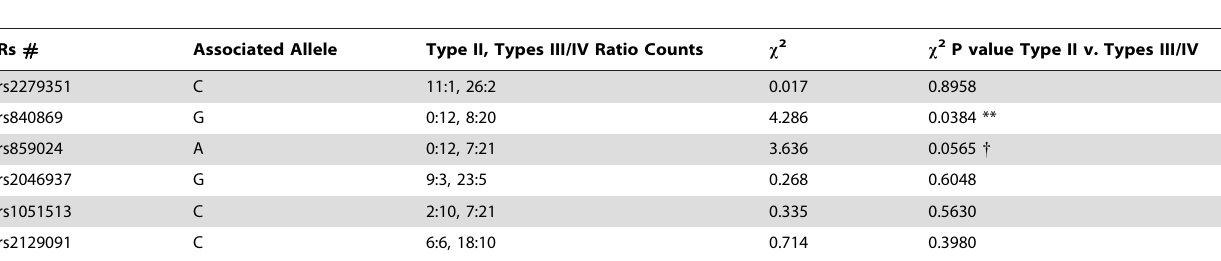
Table 2. FGFR1OP2/wit3.0 SNP minor allele distribution and association with ACP Type II group and Types III/IV group. and UCLA archival DNA.